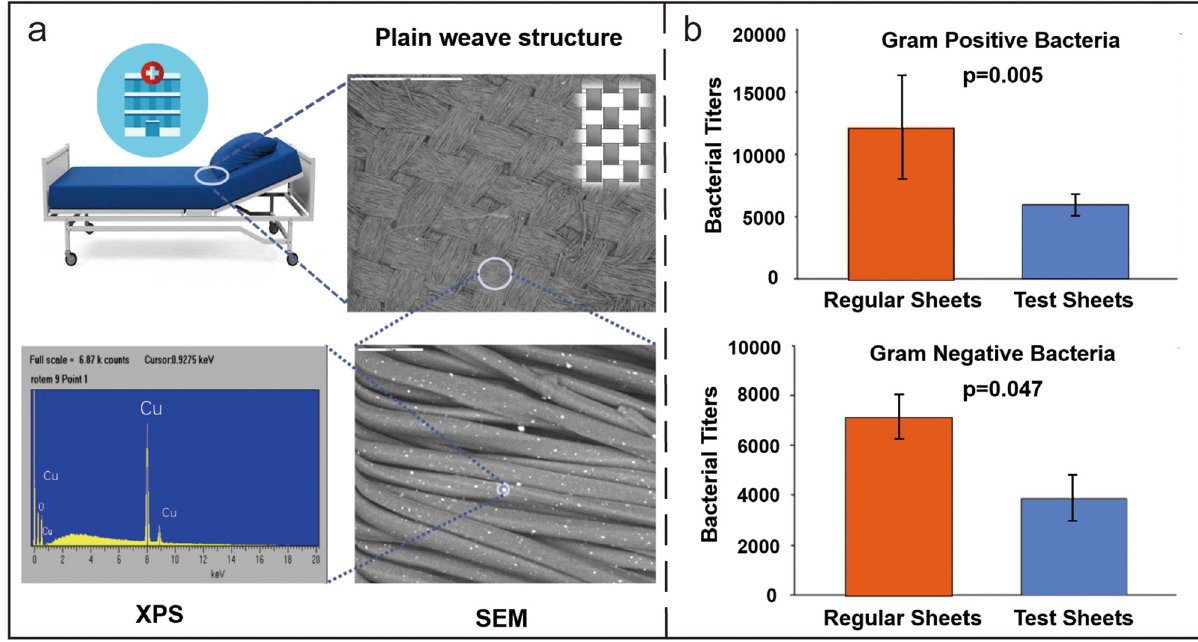
Figure 9: ( a ) Scanning electron microscope images of two representative pillowcases are shown. The white dots are copper oxide particles embedded in polyester fi bers. ( b ) Bacterial loads were found in conventional and copper oxide impregnated sheets. Forty conventional sheets and Forty copper oxide impregnated sheets were swabbed immediately after being used by patients for 6 – 7 h. Swabs were taken from the area in contact with the patient ’ s upper back [ 118 ]